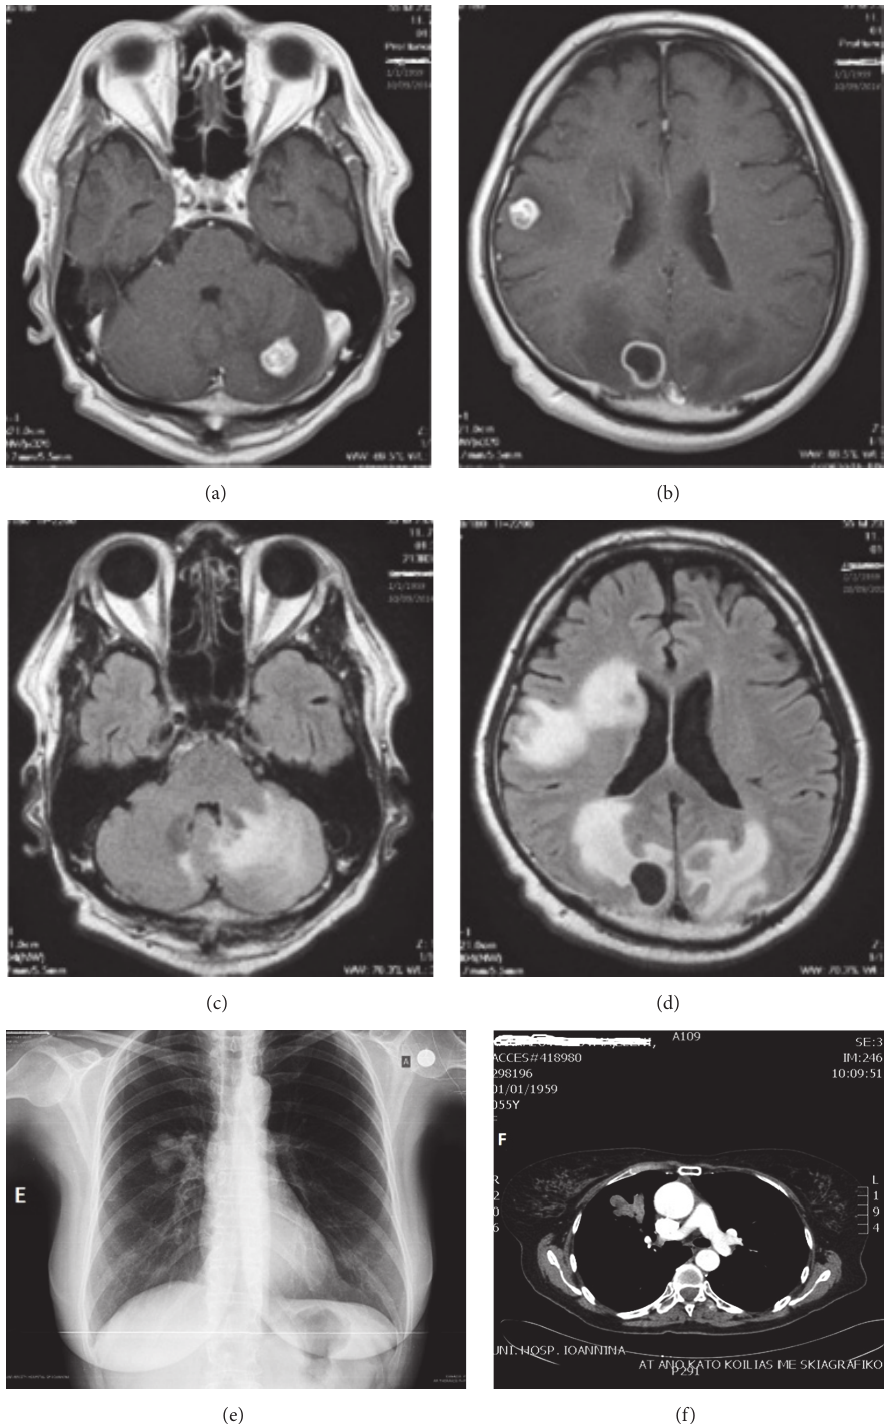
Figure 1: ((a) and (b)) Postgadolinium T1-weighted MR images demonstrate multiple enhancing nodular lesions throughout both cerebral and cerebellar hemispheres, several of which have an unusual lamellated pattern of enhancement. ((c) and (d)) T2-weighted and FLAIR MR images with paired postgadolinium T1-weighted images demonstrate significant vasogenic edema associated with several of these lesions. (e) Chest X-ray showing tumor in the anterior segment of right upper lobe. (f) Chest CT showing tumor in the anterior segment of right upper lobe with ill-defined shape and right hilum lymph